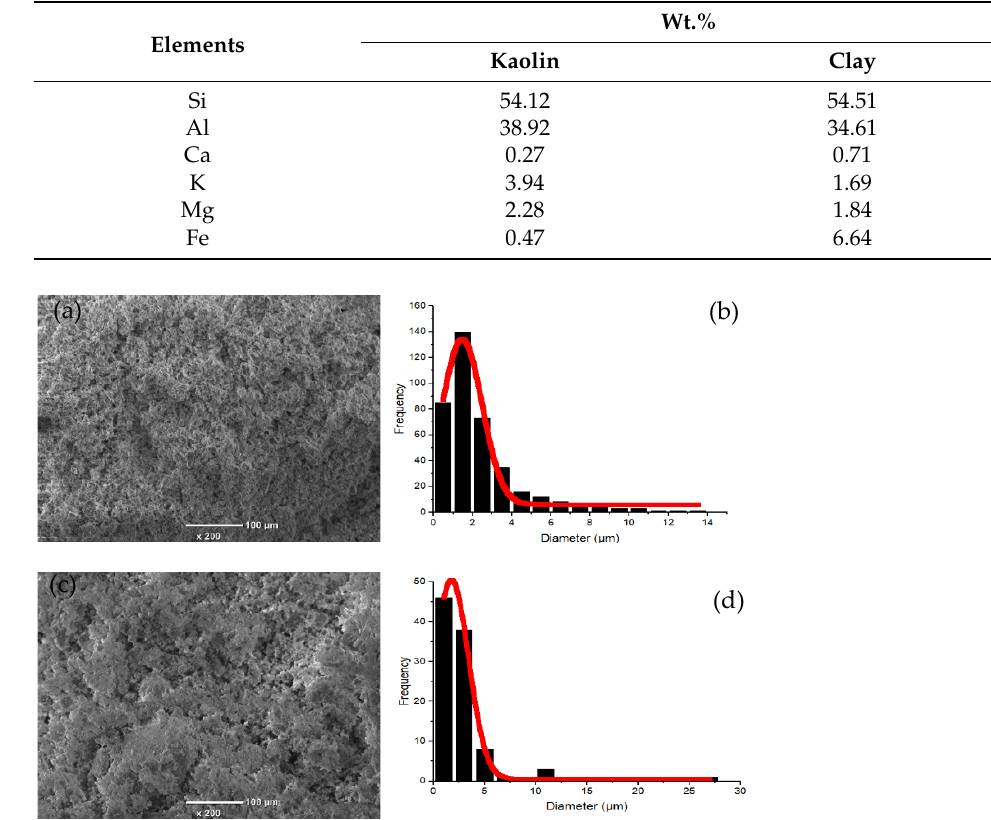
Figure 1. Morphologies and particle size distribution of the kaolin ( a , b ) and clay ( c , d ).